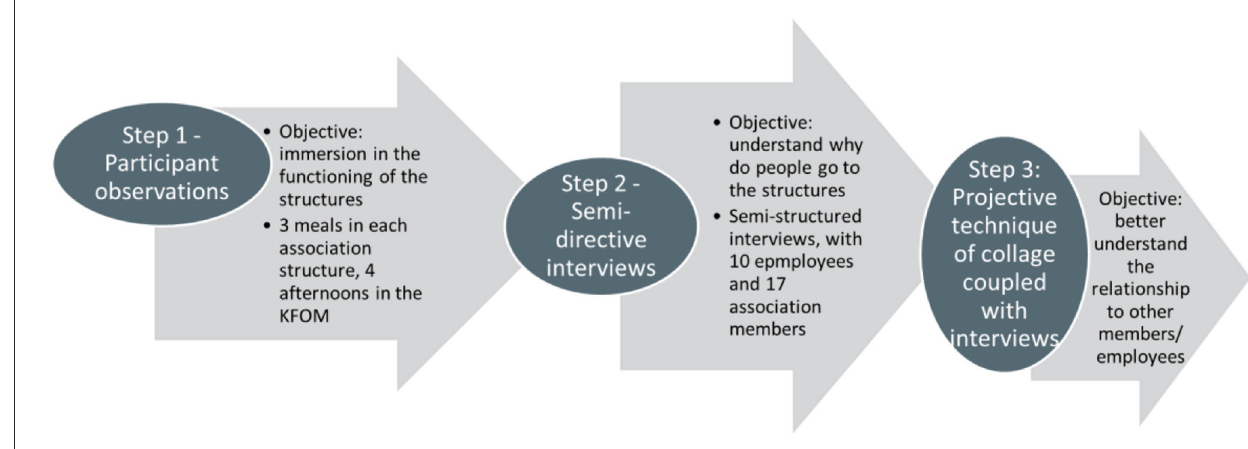
FIGURE1 Overview of the qualitative three-stages methods.